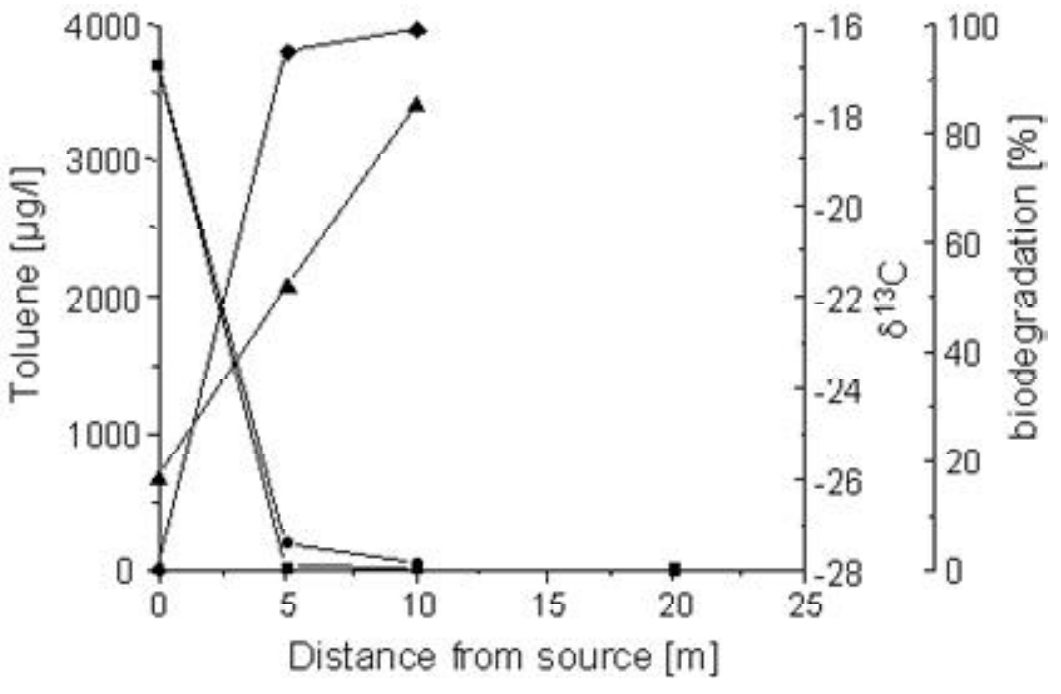
FIGURE 4. Concentrations (squares) and 13 C/ 12 C isotope ratios (triangles) of toluene along the monitoring profile (A – E) of a contaminated aquifer (Hamburg, Germany). The percentage of biodegradation (circles) and theoretical residual toluene fraction (diamonds) are calculated with Eqs. 4 and 5 using a carbon isotope fractionation factor for anaerobic biodegradation (adapted from